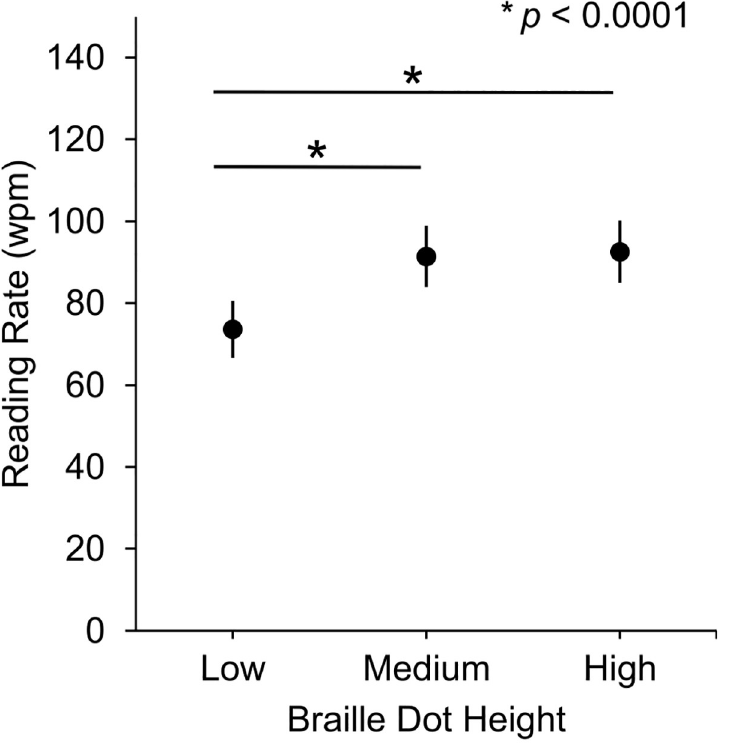
Fig 2. Average readings rates (with SEMs) at three braille dot